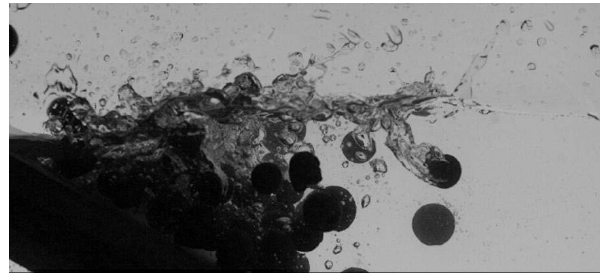
Figure 1. The spread of granular particles in